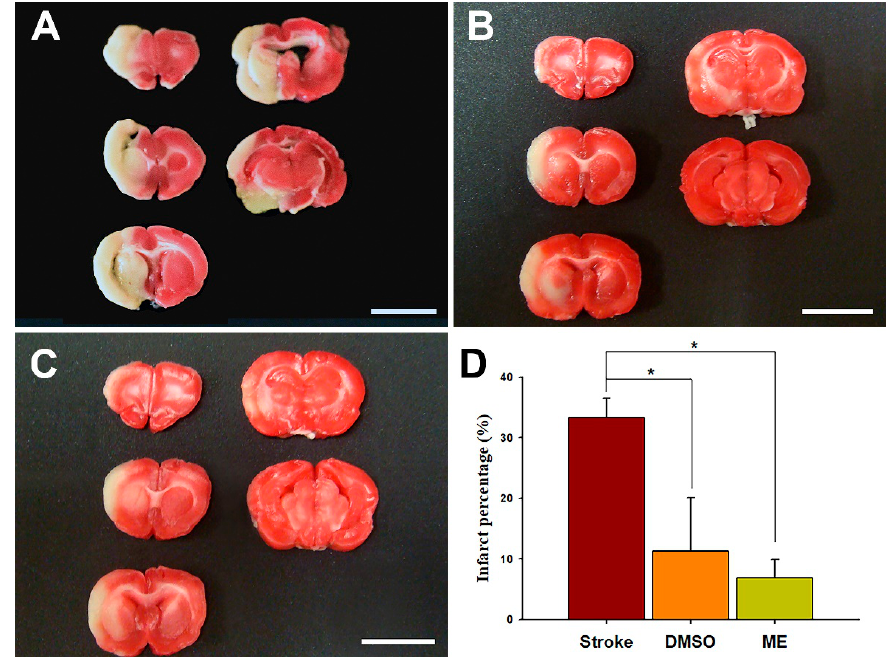
Figure 7. Effects of magnolol in DMSO and in ME on the brain infarct volume using an ischemic rat model. Magnolol was intraperitoneally administrated at 30 mg/kg 90 min after onset of ischemia. Brain infarction size was assessed by TTC staining present in 2 mm thick coronal sections from the rat brains after 24 h of ischemia. ( a ) Stroke group without treatment, ( b ) magnolol in the DMSO group, ( c ) magnolol in the ME group, and ( d ) mean percentage of brain infarct area. Scale bare = 1 cm. Data are expressed as mean ± SD of six independent experiments. * p < 0.05; one-way ANOVA (Bonferroni). ME, microemulsion group.